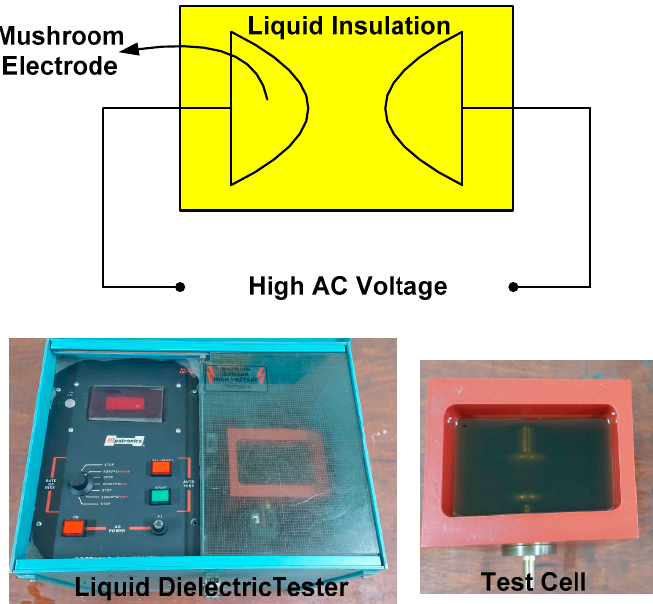
Figure 3. Experimental setup for breakdown strength of transformer oil samples.